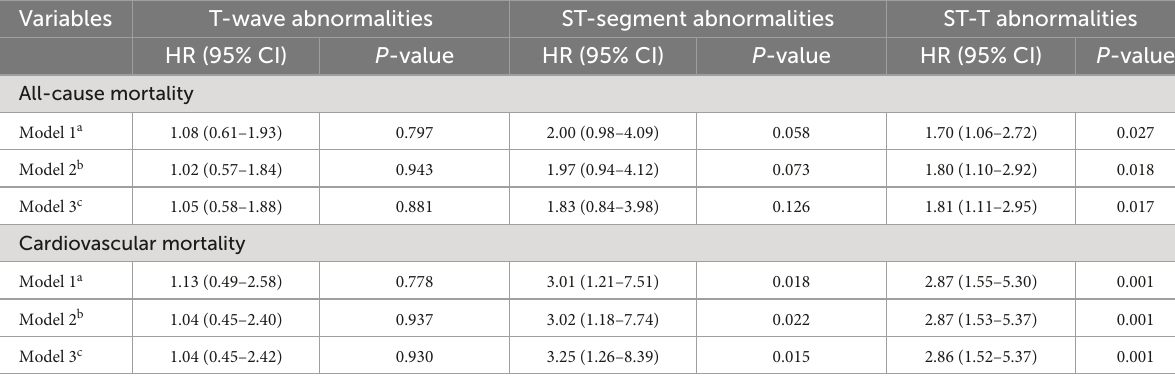
TABLE 2 The associations of ST-segment and/or T-wave abnormalities with all-cause and CVM.